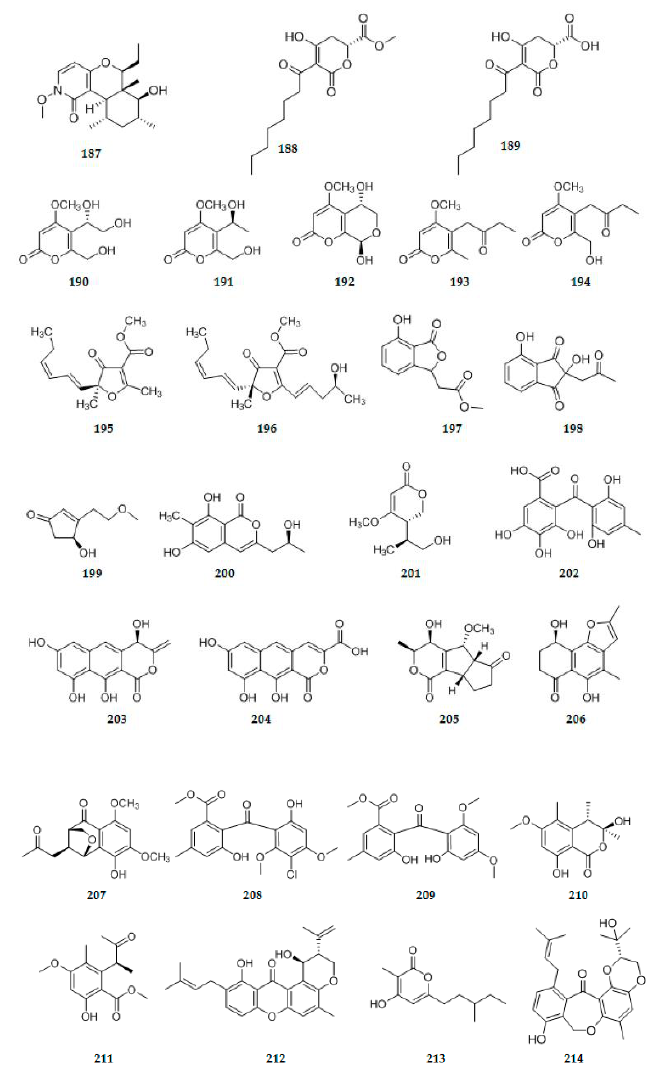
Figure 6. Chemical structures of other